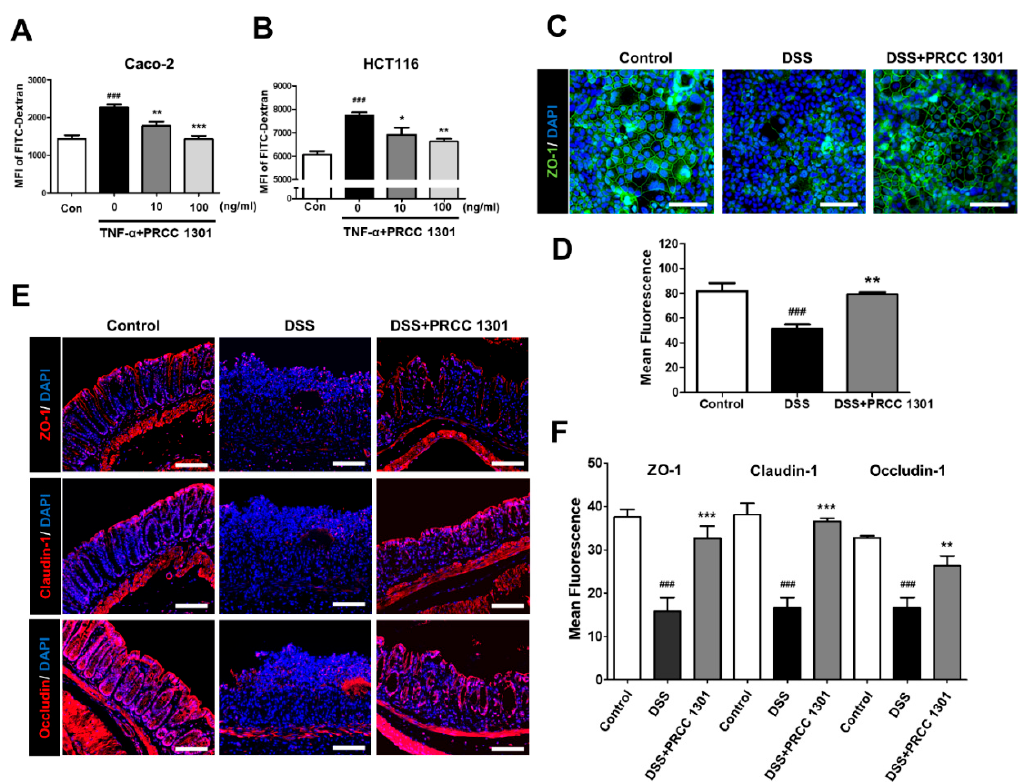
Figure 2. PRCC-1301 EVs recovered increase in intestinal permeability and disruption of tight junction complexes. In vitro permeability assay was performed in ( A ) Caco-2 and ( B ) HCT116 cells treated with TNF- α in the absence or presence of PRCC-1301 EVs. The results are shown as mean ± SEM. ### p < 0.001 compared with control, * p < 0.05, ** p < 0.01, and *** p < 0.001 compared with TNF- α -treated group. ( C ) Expression of ZO-1 in Caco-2 cell monolayers incubated with 2.5% DSS in the absence or presence of PRCC-1301 EVs. ( D ) Quantification for ZO-1 fluorescence. The results are shown as mean ± SEM. ### p < 0.001 compared with control, ** p < 0.01 compared with DSS group. ( E ) Expression of ZO-1, claudin-1, and occludin was examined in control, DSS, and PRCC-1301 EV-treated mouse colon tissue. ( F ) Quantification for ZO-1, claudin-1, and occluding fluorescence, respectively. Nuclei were counterstained with 4, 6-diamidino-2-phenylindole (DAPI). The results are shown as mean ± SEM. ### p < 0.001 compared with control, ** p < 0.01 and *** p < 0.001 compared with DSS group. Scale bar = 100 μ m .